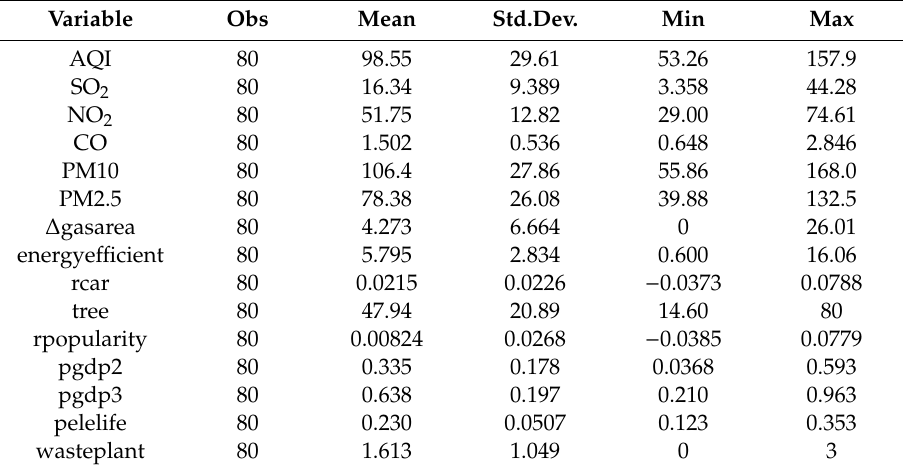
Table 2. Summary statistic of variables in the